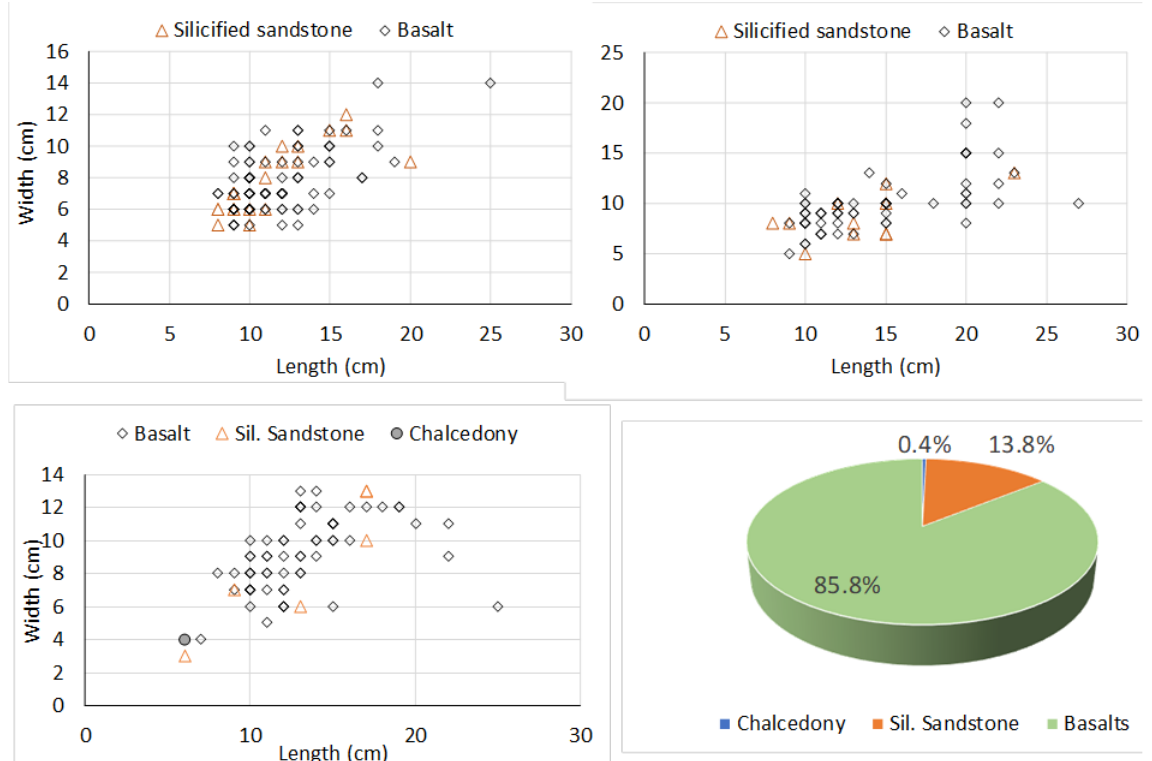
Figure 14. Lithologies and sizes (rounded) of the pebbles and cobbles analysed in the sampling units located at the Uruguay, Ariranha and Taquarussú rivers (Santa Catarina State). The basalts may include a small fraction of andesites, rhyodacites and rhyolites. The pie chart includes all the samples of the three rivers.